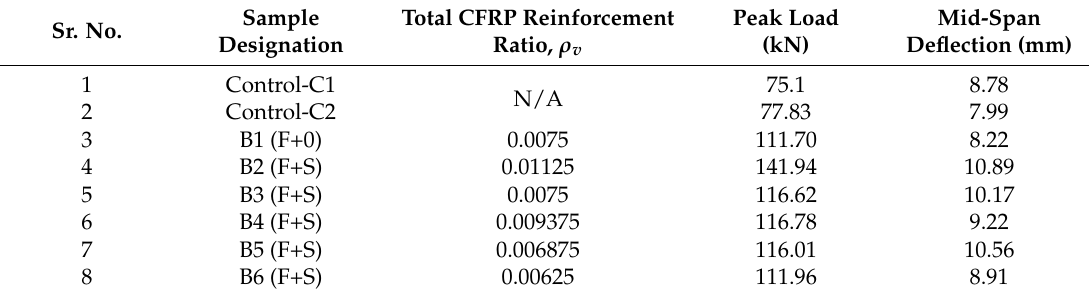
Table 6. Beam sample peal loads and deflections.